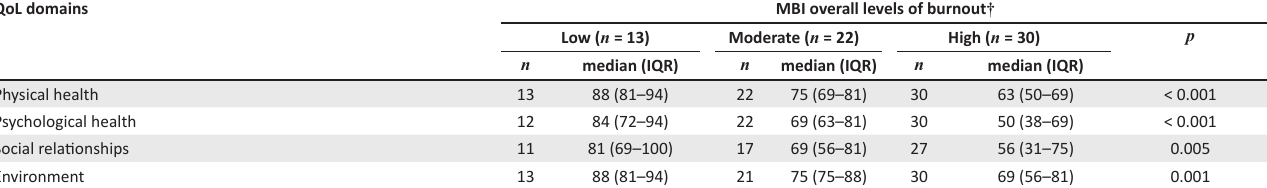
TABLE 3: Median scores of the quality of life domains in the Maslach Burnout Inventory overall categories. QoL